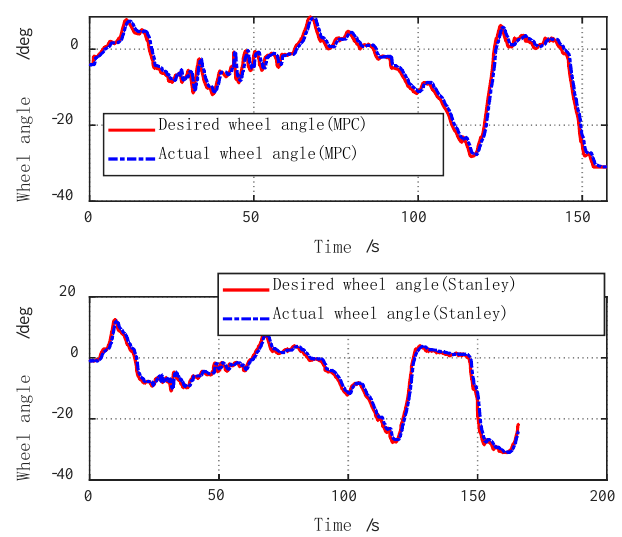
Figure 13. Global trajectory of MPC control and Stanley control.